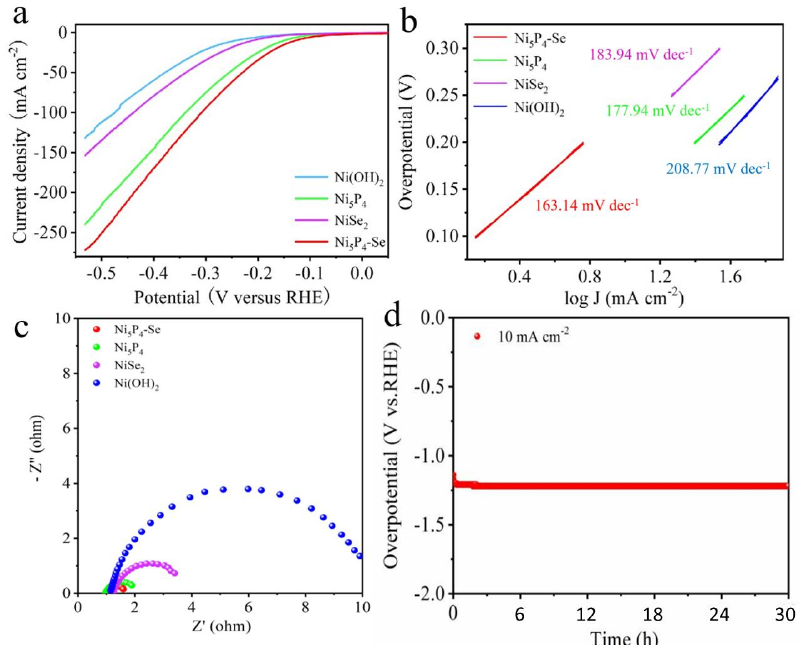
Figure 3. ( a ) Polarization curve, ( b ) Tafel slope, ( c ) Nyquist plots of Ni(OH) 2 , Ni 5 P 4 , NiSe 2 , Ni 5 P 4 − Se samples measured in 1 M KOH electrolyte., ( d ) V-t curves of Ni 5 P 4 − Se at 10 mA cm − 2 .